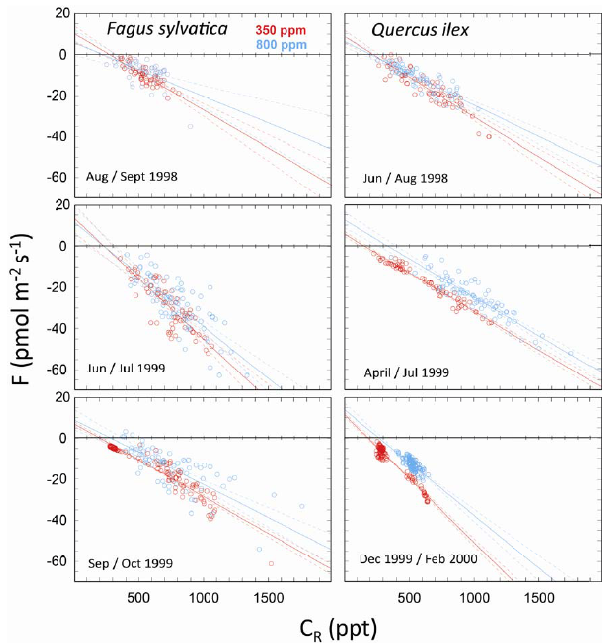
Fig. 1. Linear regression analysis of the relation between the initial COS concentration ( c R ) and the uptake by European beech ( Fagus sylvatica ) and holm oak ( Quercus ilex ) growing under two differ- ent CO 2 regimes (350 and 800ppm) beginning in March 1998 and measured at the indicated time periods. Given are the regression lines (continuous lines) together with their 95% confidence bands (broken